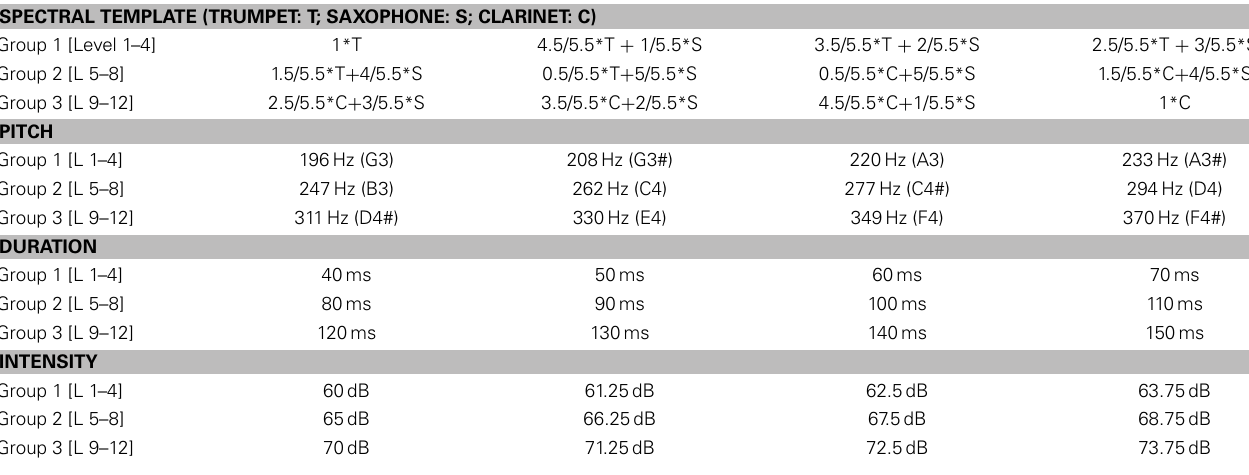
Table 1 | Stimulus parameter space for stream 1